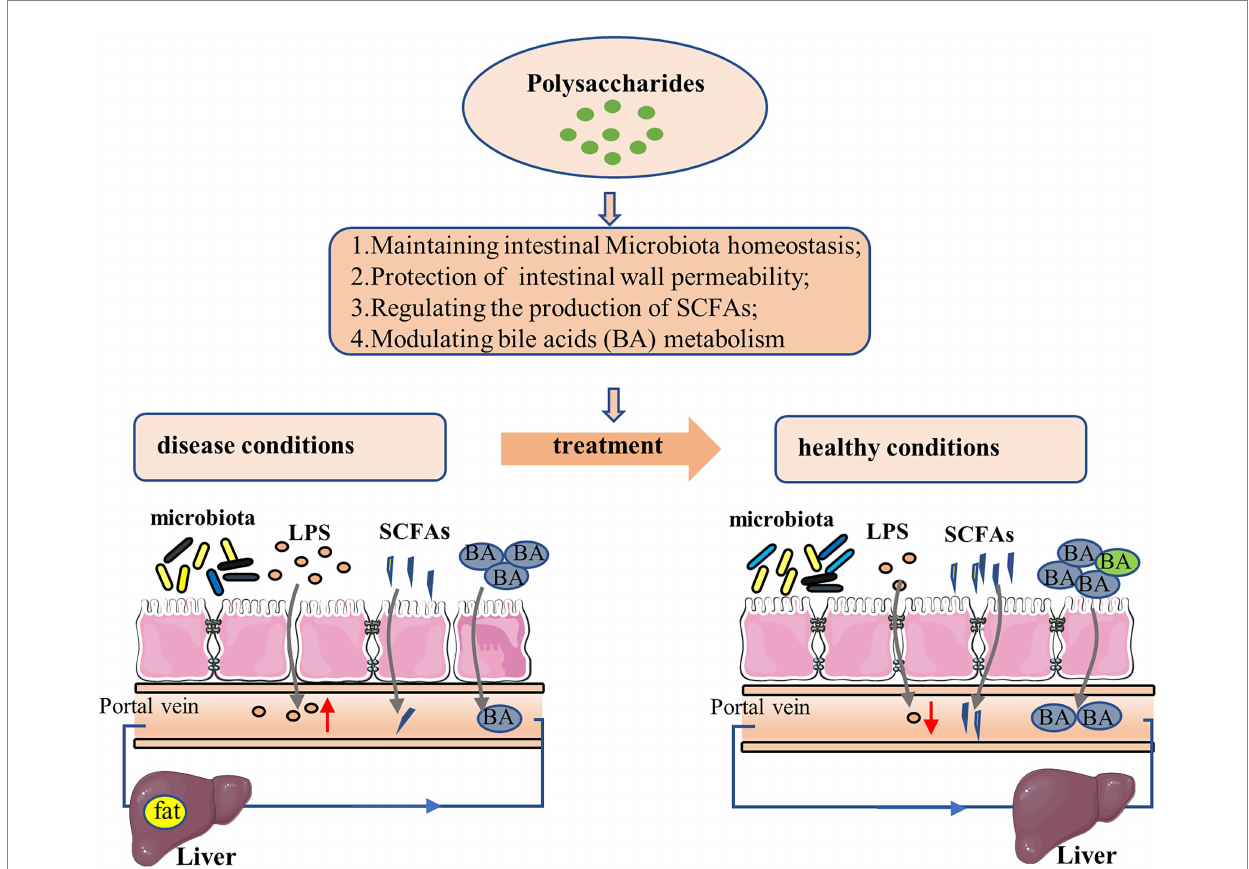
FIGURE 2 Mechanism of polysaccharide action on NAFLD via gut-liver